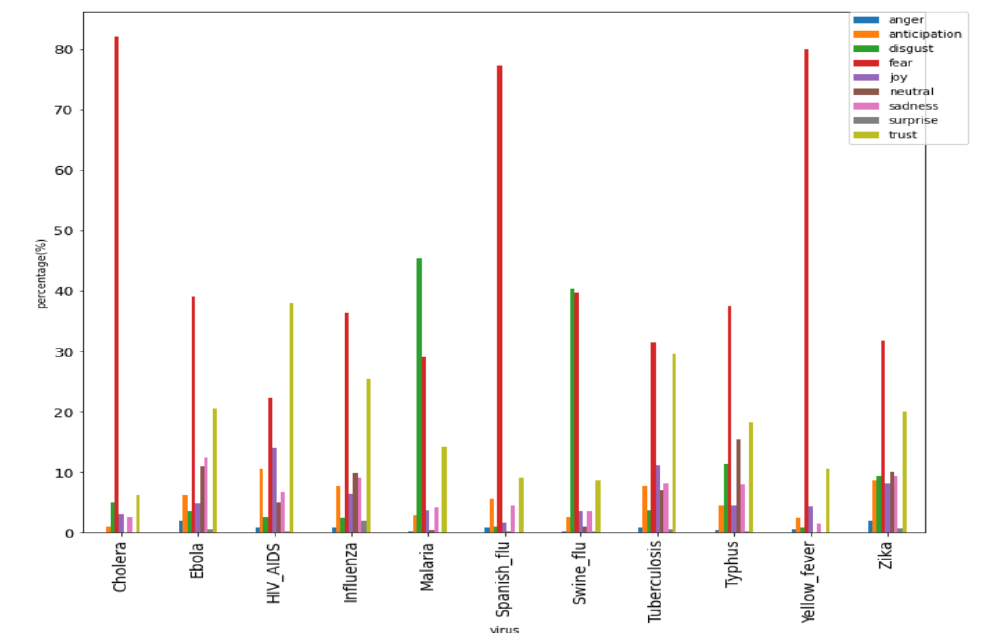
Figure 16. Emotion distribution in different